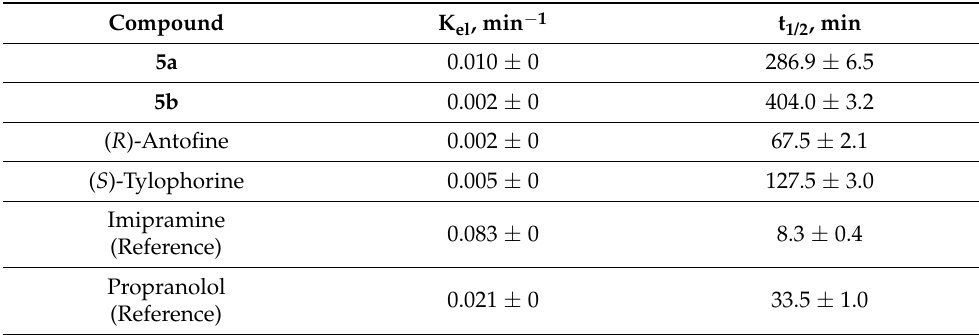
Figure 5. Mouse hepatic microsomal stability for prodrugs 5a,b and their parent alkaloids. Table 3. Mouse hepatic microsomal stability for prodrugs 5a,b and their parent alkaloids. K el : elimination rate constant, t 1/2 :